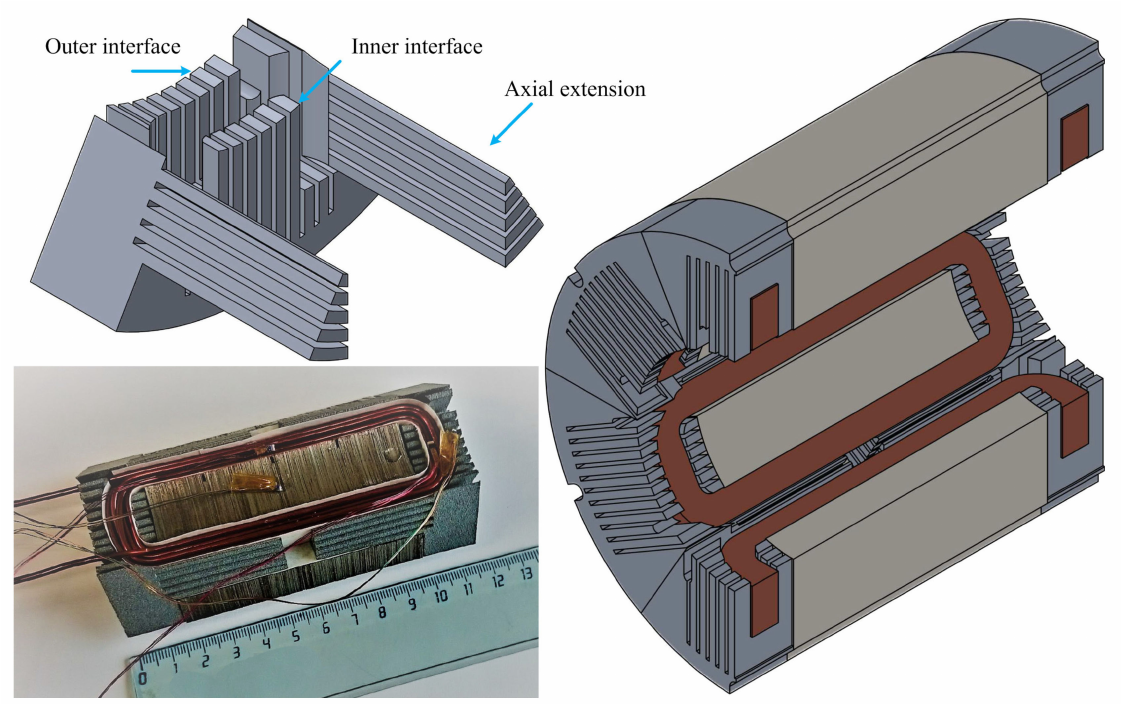
Figure 24. Extended end-winding cooling inserts with inward heat extraction fins for switched reluctance machine